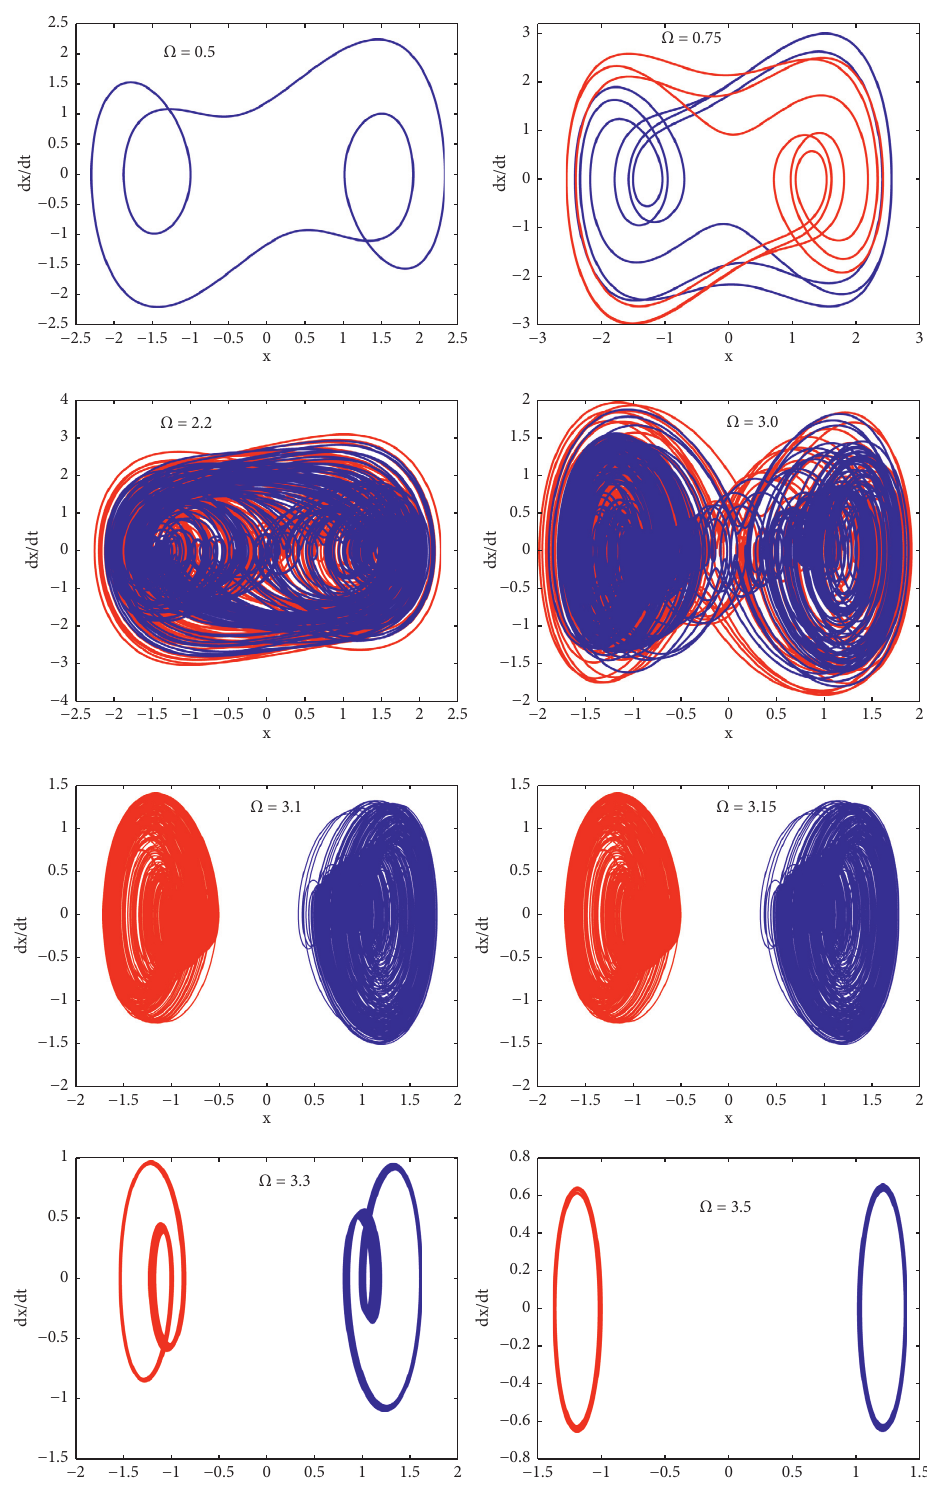
Figure 15: Various phase portraits illustrating monostability, bistability, and coexistence of attractors for different values of Ω with the parameters of Figure